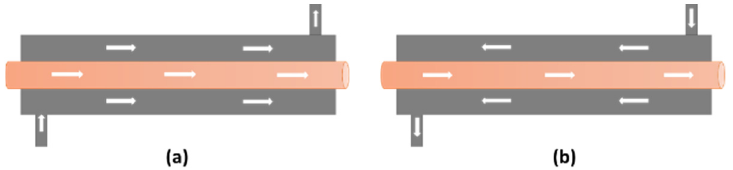
Figure 1. Double-pipe heat exchangers using ( a ) parallel flow and ( b ) counter flow [3].